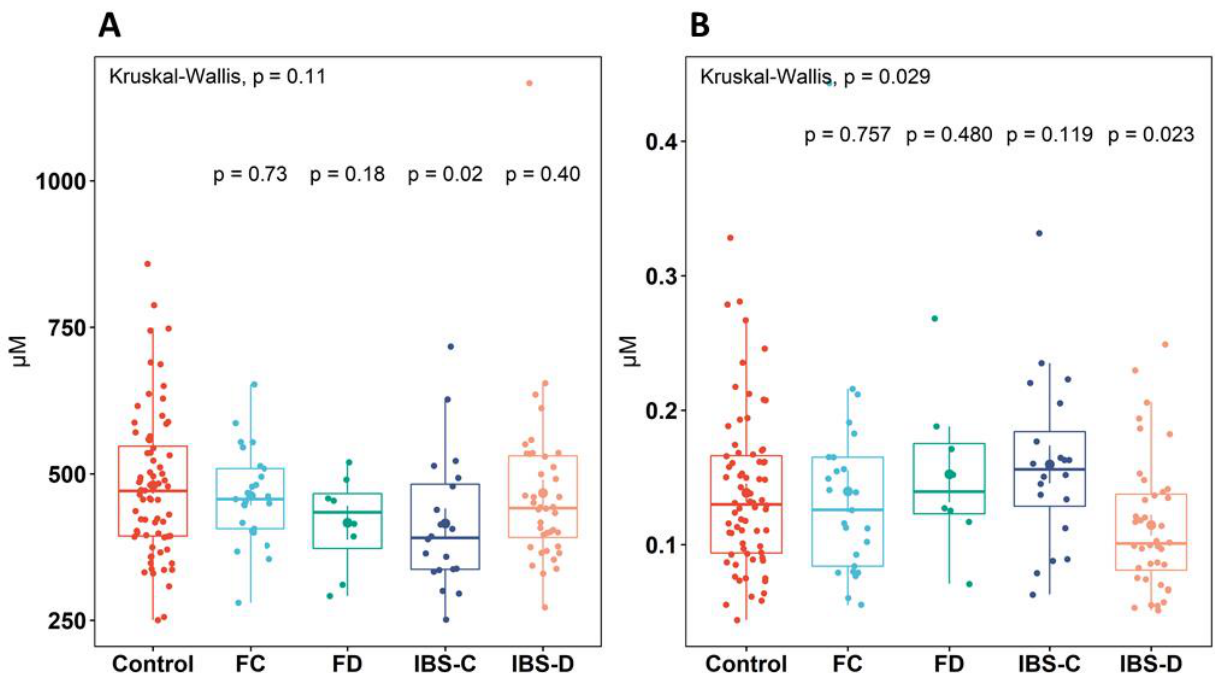
Figure 2. Significant differences found in ( A ): concentration of branched-chain amino acids (BCAAs) and ( B ): alpha-aminobutyric acid (AABA) between healthy control, IBS subtypes, and functional groups. The top significance value denotes the overall significance between all groups. Individual group significance values are pairwise comparisons between healthy controls and the group. Boxplots show the median (center line), 25th and 75th percentile (top and bottom of boxes, respectively), and whiskers representing 1.5 times the interquartile range. Abbreviations: healthy control (control), functional constipation (FC), IBS-constipation (IBS-C), functional diarrhea (FD), IBS-diarrhea (IBS-D). Colors identifies subtype or healthy control groups.